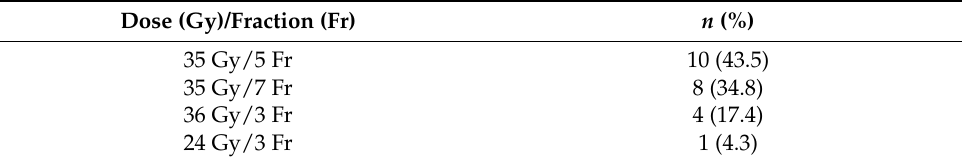
Table 2. Dose fractionation